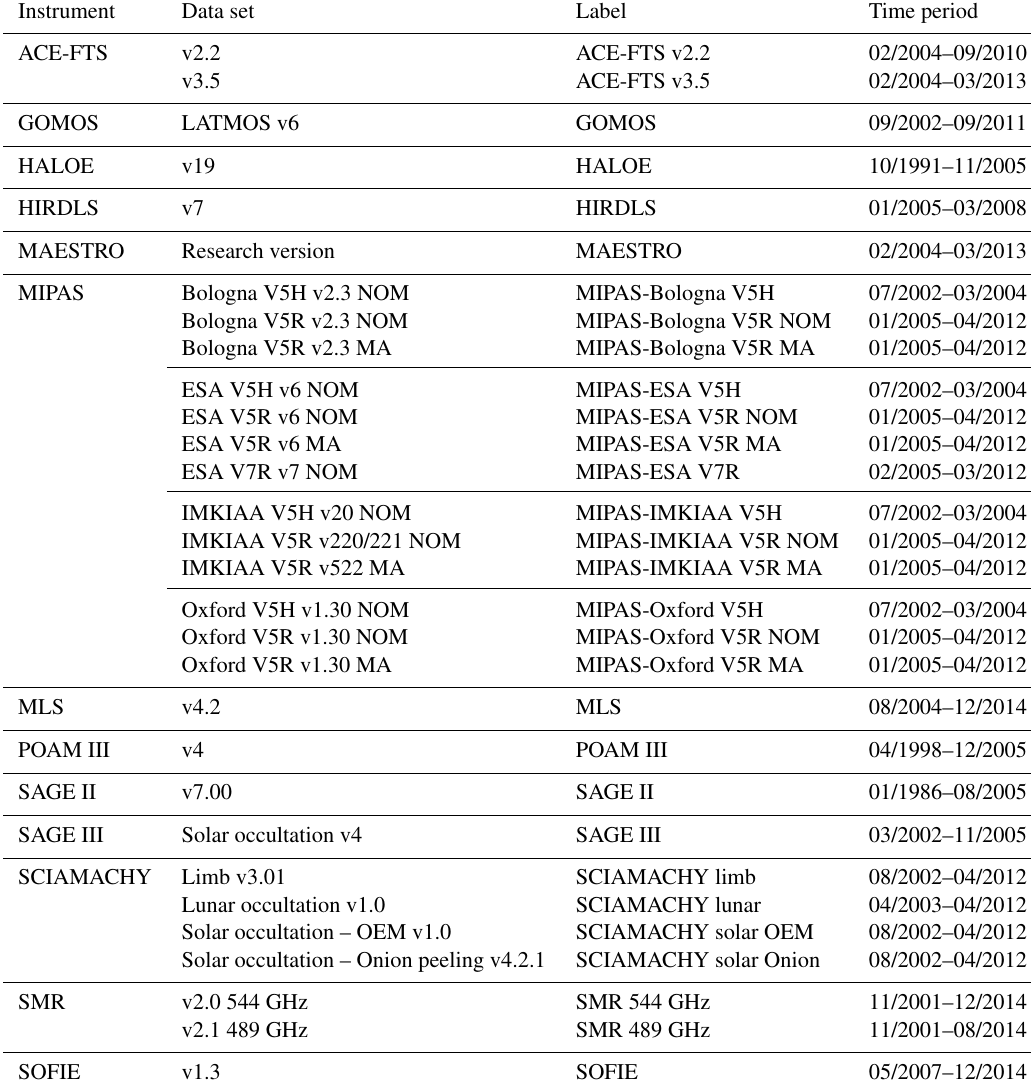
Table 1. Overview over the water vapour data sets from satellites used in this study.